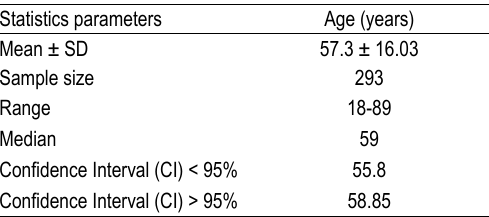
Table 1. Mean age of patients with GiB treated with blood